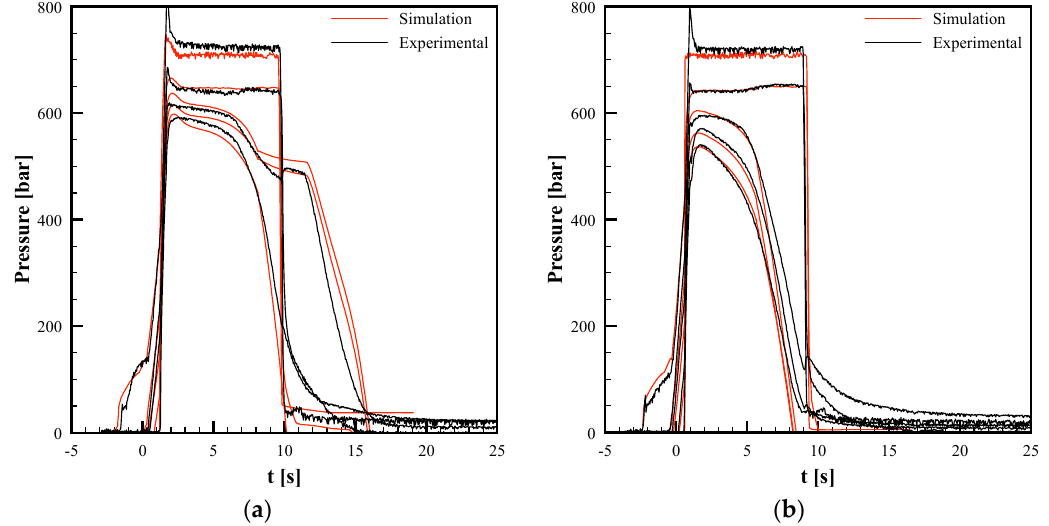
Figure 5. Recorded (black lines) and simulated (red lines) pressure evolutions during the injection molding tests for ( a ) the passive condition and ( b ) activating the heating devices with an electrical power density of 10 W/cm 2 and heating time of 13 s.